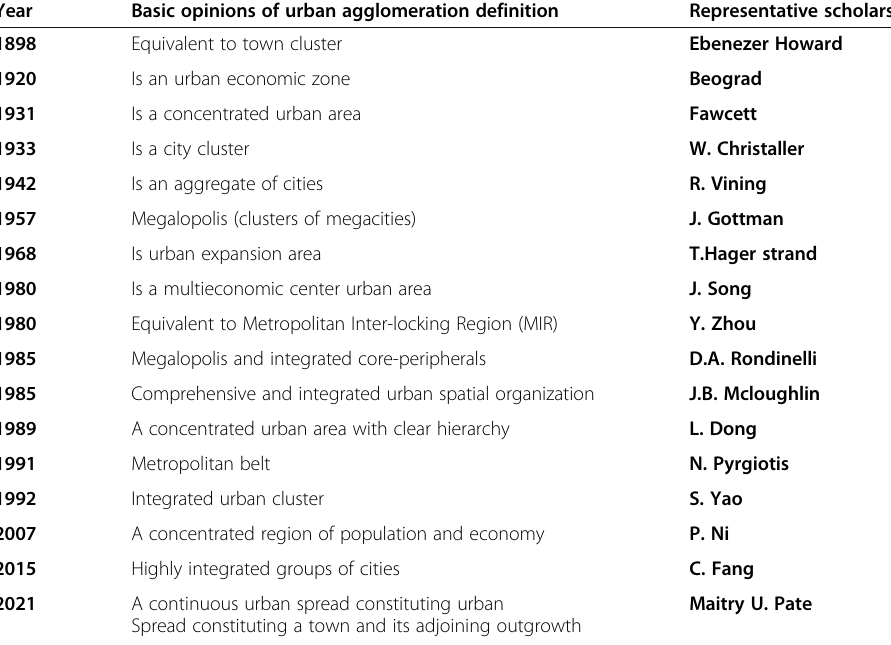
Table 1 Urban agglomeration definitions